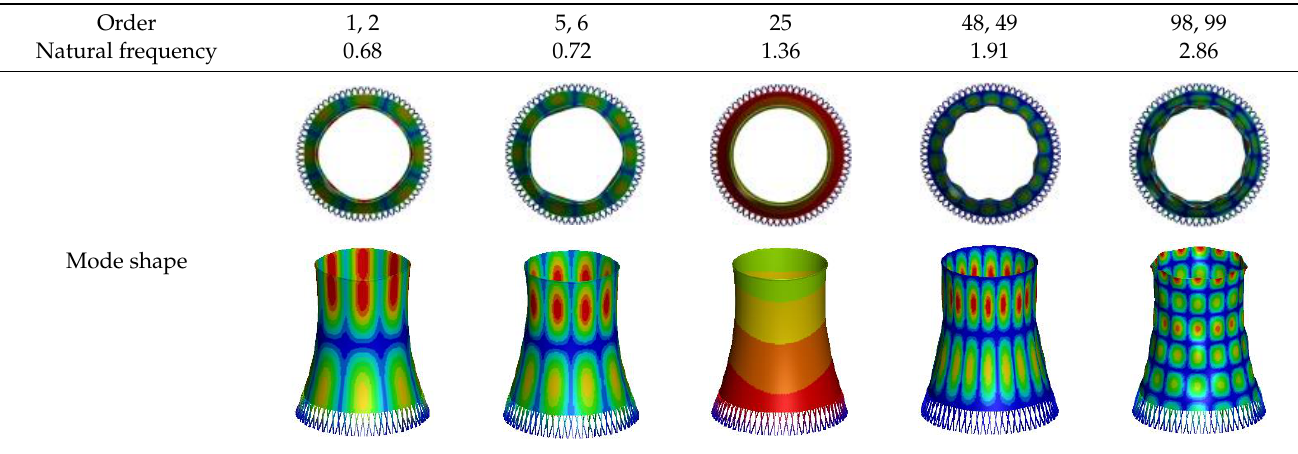
Table 4. List of natural frequencies and mode shapes of typical cooling towers.